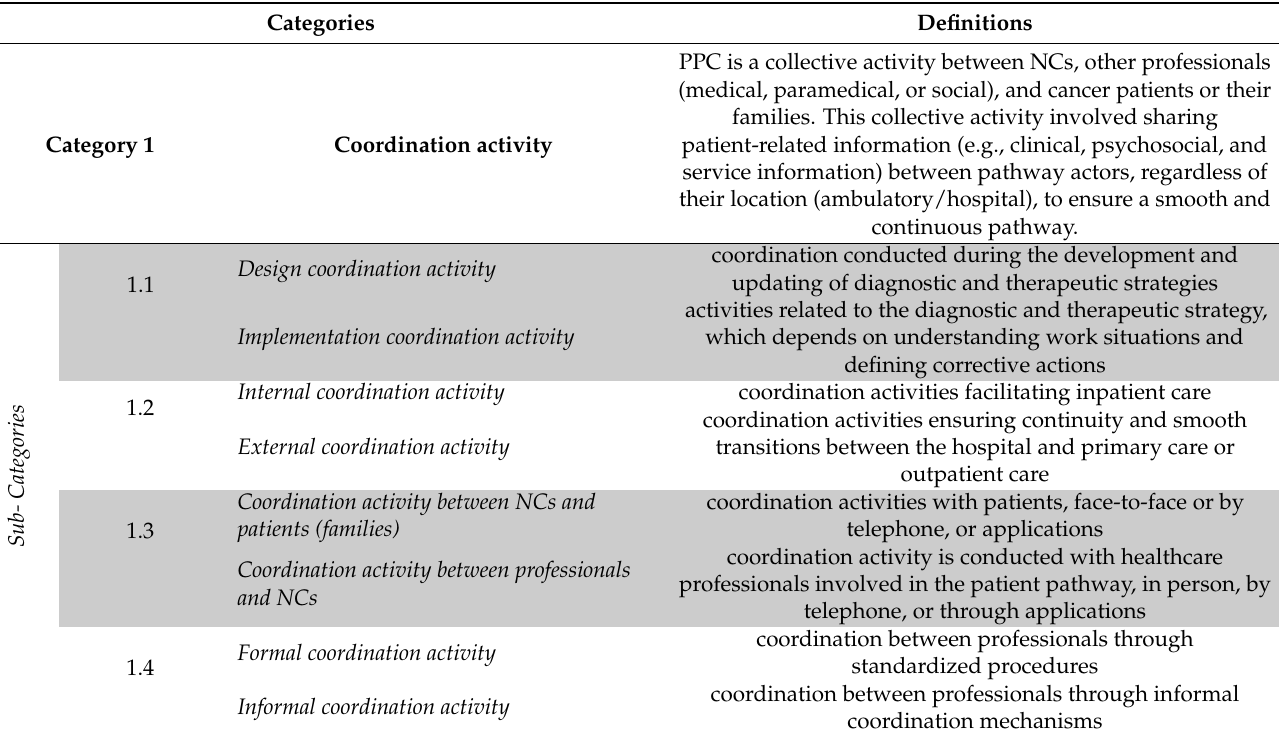
Table 2. APANCO framework